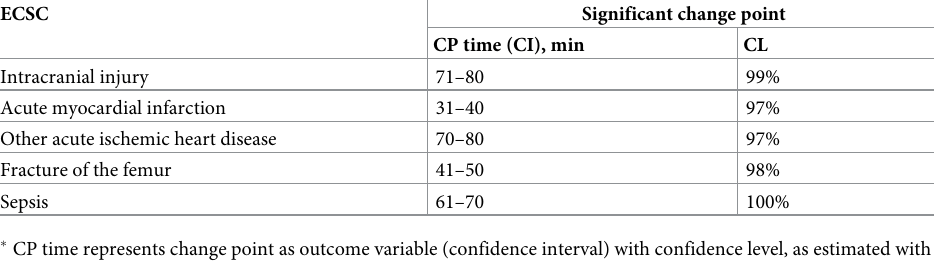
Table 3. Change points of adjusted 30-day mortality per ECSC.